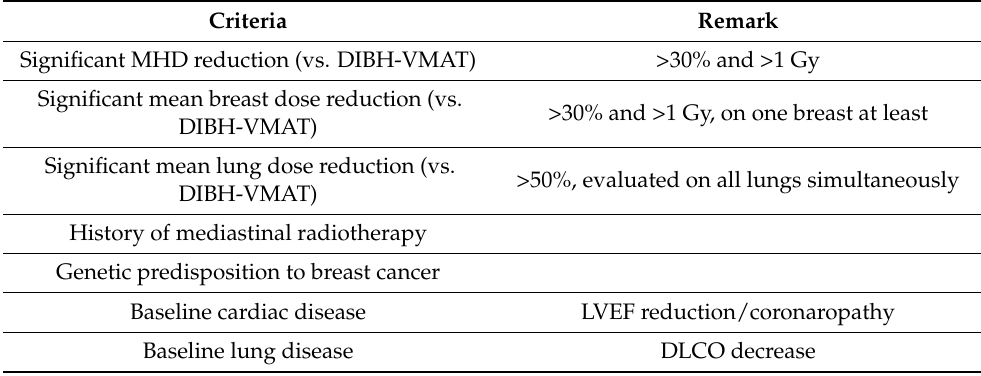
Table 1. Selection rules for Hodgkin lymphoma proton therapy based on the dosimetric compari- son, currently in use at Institut Curie, Paris, France. The selection process relies on a competitive dosimetric comparison between VMAT and proton therapy, both simulated with deep-inspiration breath-hold (DIBH). Clinical characteristics of the patient are taken into account. One fulfilled cri- terion is sufficient. DIBH-VMAT: deep inspiration breath-hold volumetric modulated arc therapy. LVEF: left ventricle ejection fraction. DLCO: Diffusing capacity for carbon